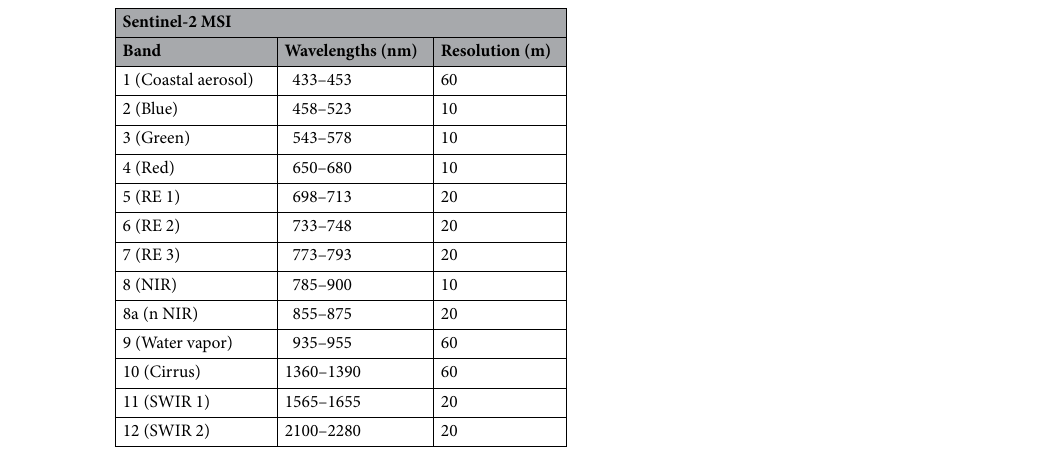
Table 1. Spectral bands of Sentinel-2 MSI